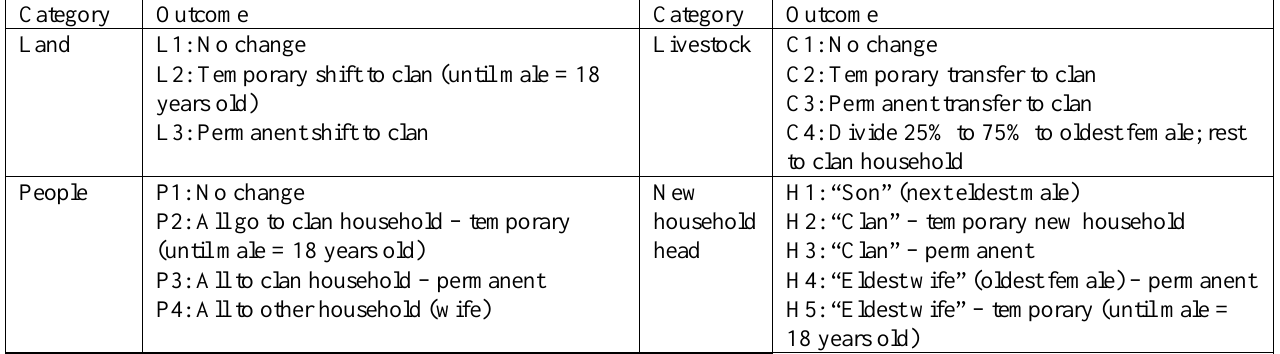
Key for resource distribution outcomes from Figure